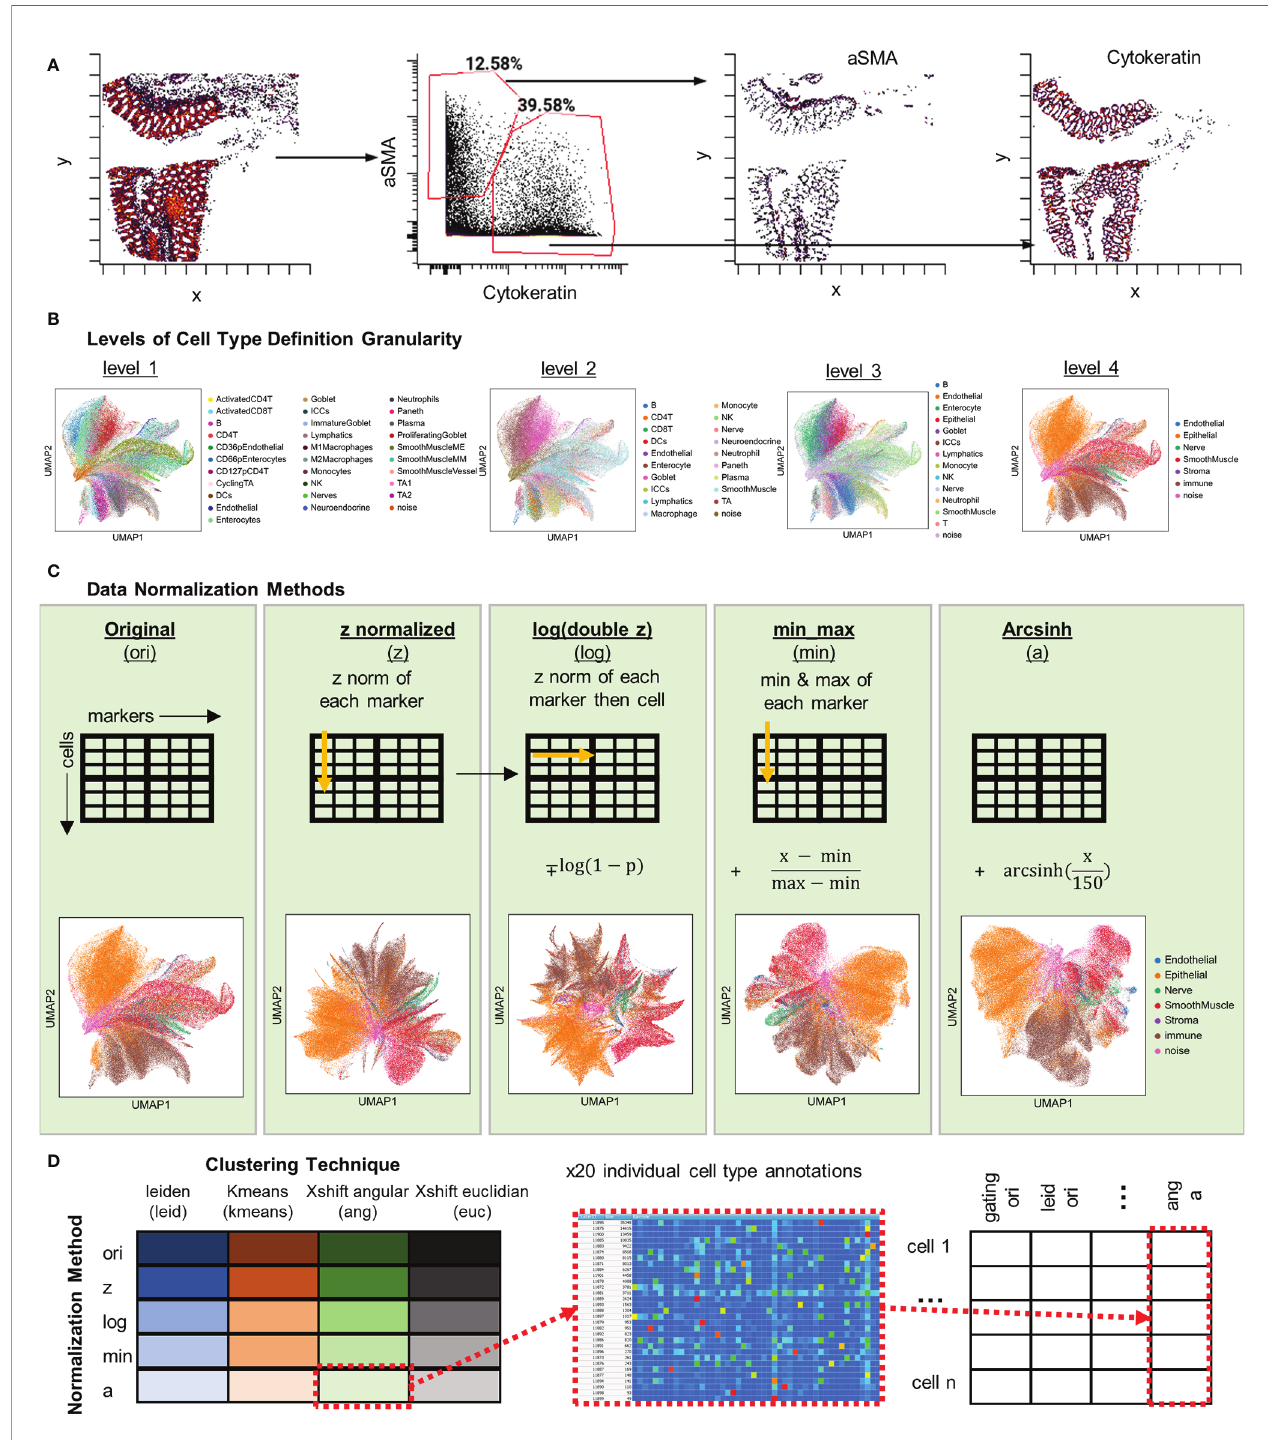
FIGURE 2 | Strategies used for cell type annotation via fi ve methods of data normalization and four clustering algorithms. (A) Far left: Spatial plot of x, y positions cells gated based on quanti fi ed fl uorescent signal for aSMA and Cytokeratin. Plots to the right: Single-positive gating shows location of identi fi ed populations with the same x, y positions. (B) Cell-type comparisons at four levels of granularity with the level 1 having the highest degree of granularity of 35 cell types and level 4 having the lowest degree of granularity of 7 types. (C) Schematic of data treatment and representative UMAP plots for, from left to right, original CODEX data, Z normalized data, log(double Z) transformed data, min-max normalized data, and arcsinh normalized data. (D) Data, normalized or not, was clustered using the Leiden algorithm, k- means, X-shift with Euclidian distance, or X-shift with angular distance. All cell type annotations were merged for each cell and combined into one dataset for comparison of